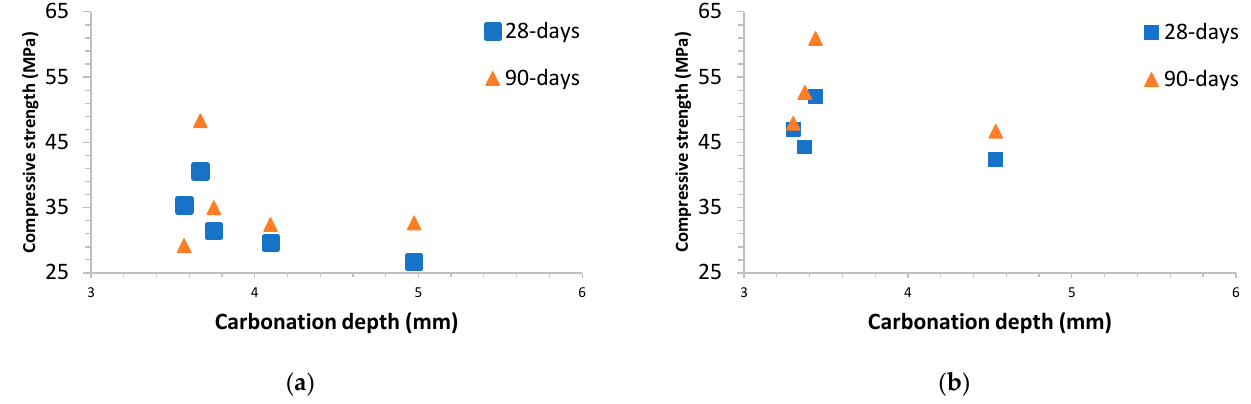
Figure 4. Carbonation depth of concrete samples at 12 months.